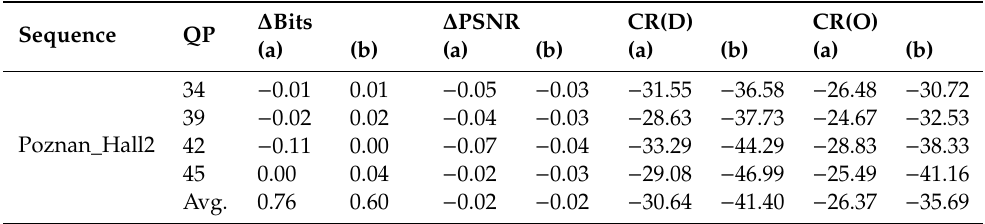
Table 5. Detailed information of (a) the FHEVCI + DMMS method and (b) the proposed method.